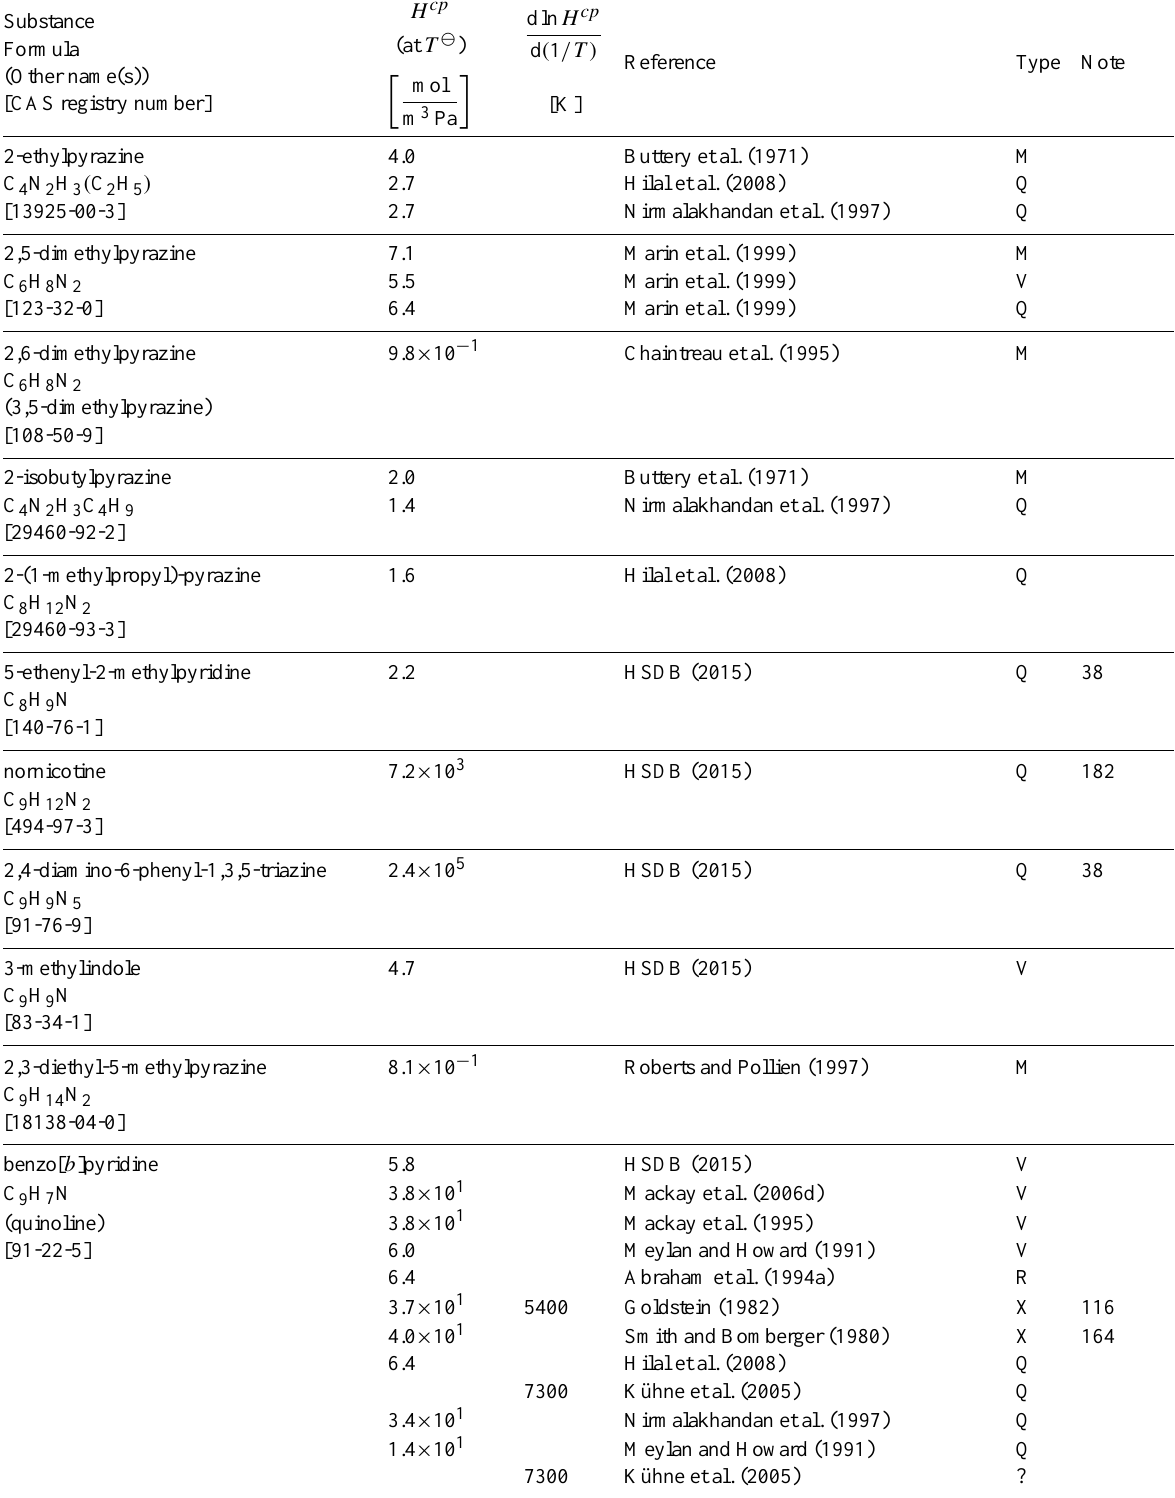
Table 6: Henry’s law constants for water as solvent